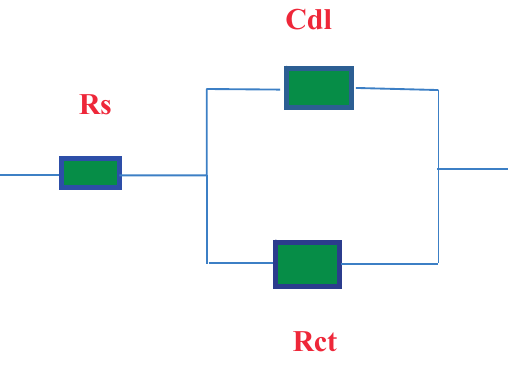
Figure 12. Equivalent circuit employed for fitting EIS